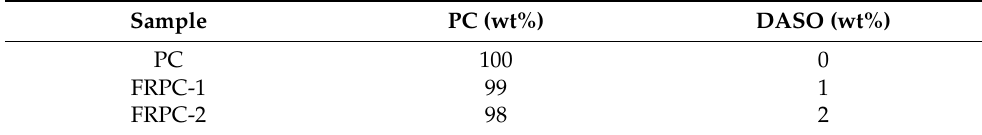
Table 1. Formula table of PC and FRPCs.